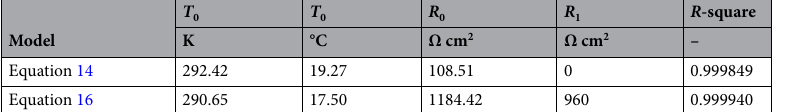
Table 7. Optimal adjustable parameters’ values of the two hyperbolic suggested models Eqs. (14), and (16) for overall the three